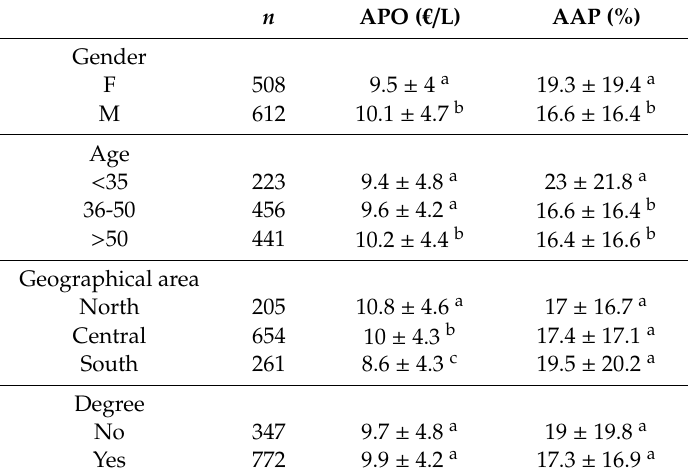
Table 6. Average values and standard deviations of mean purchase for high quality extra virgin olive oil (EVOO) (APO) and acceptable additional cost to pay for traceability technologies (AAP) with respect to gender, age class, geographical area (Italy), and university degree. n